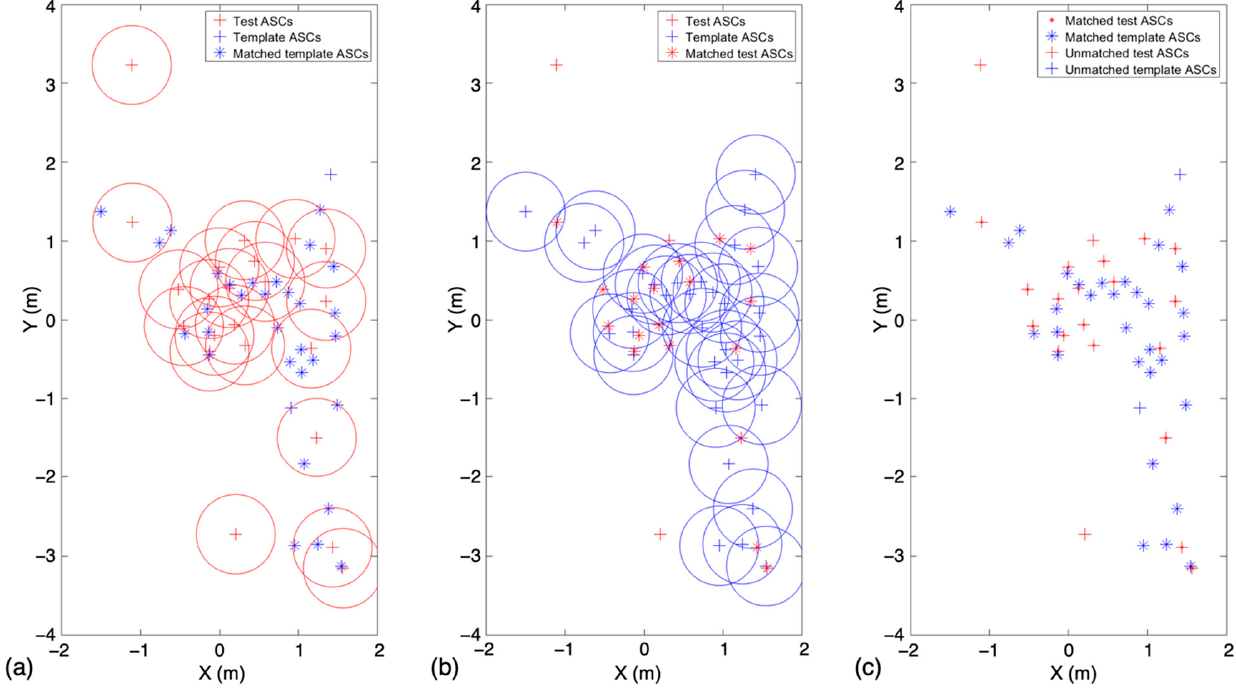
Figure 4. Example of neighbor matching: ( a , b ) neighbor matching based on the coordinates of the test ASC and template ASC, respectively. ( c ) Result of neighbor matching.